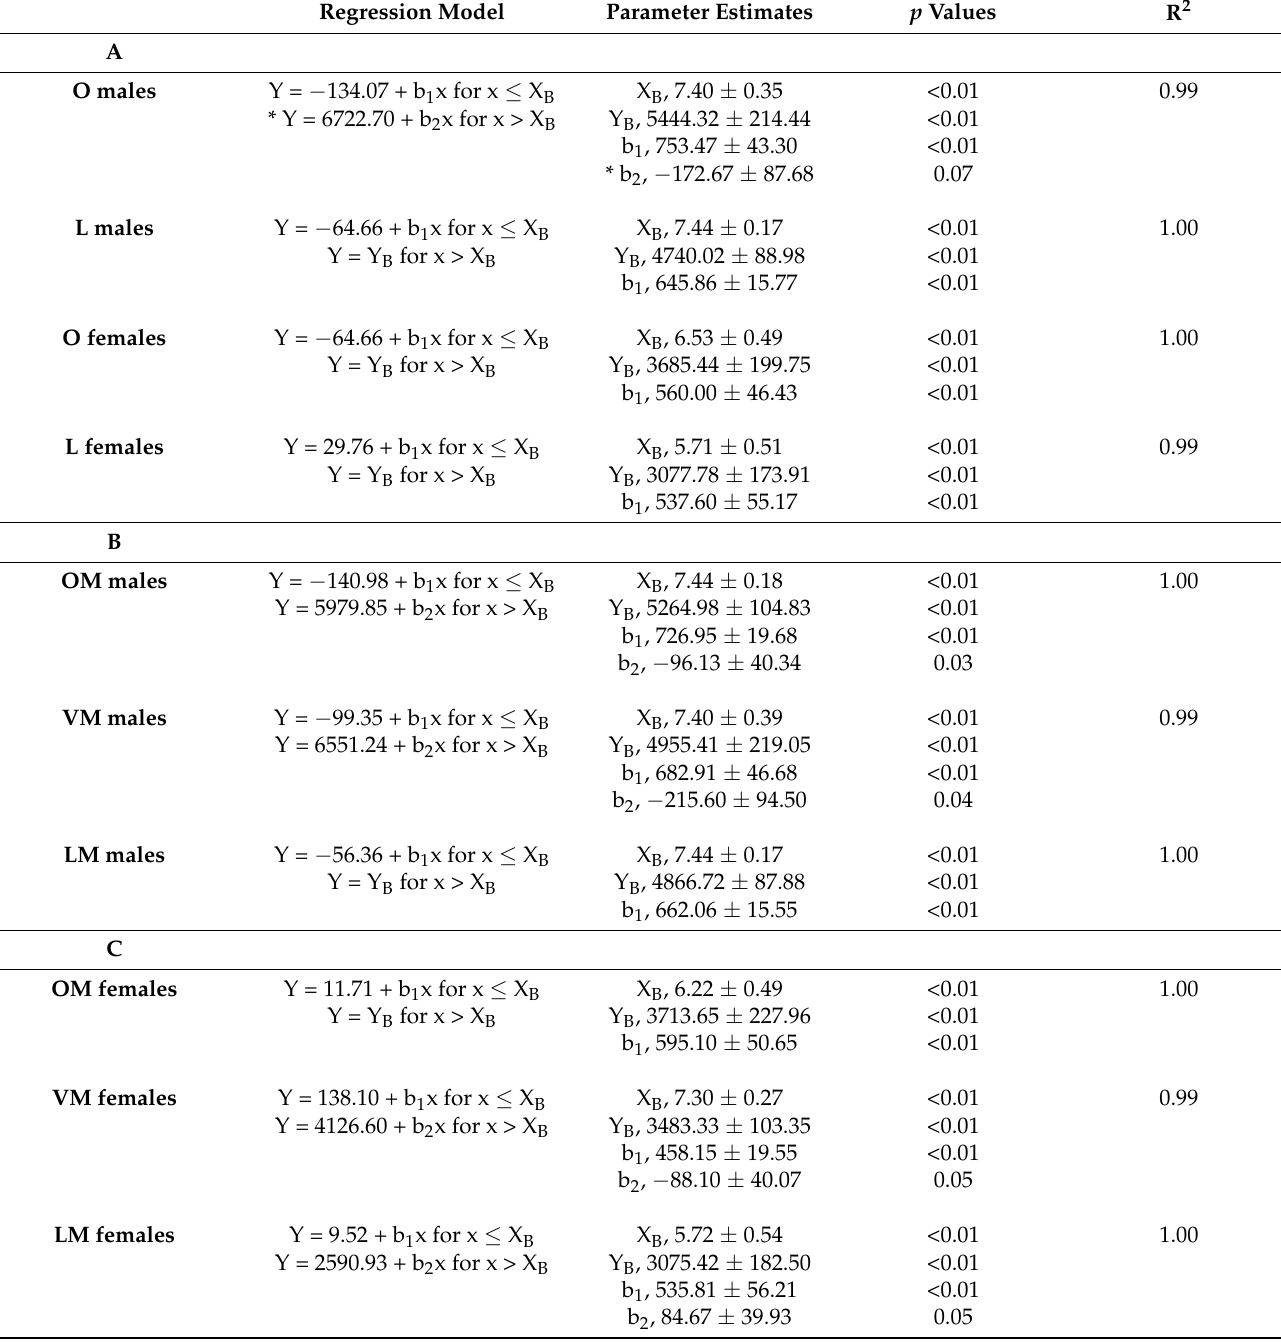
Table 1. Linear broken-line regression equations based on monthly averaged body weight (see Table S1), ( A ) according to sex and body condition score (BCS) at 8 months, ( B ) for males according to maternal phenotype, ( C ) for females according to maternal phenotype (see Figure 1 for graphical